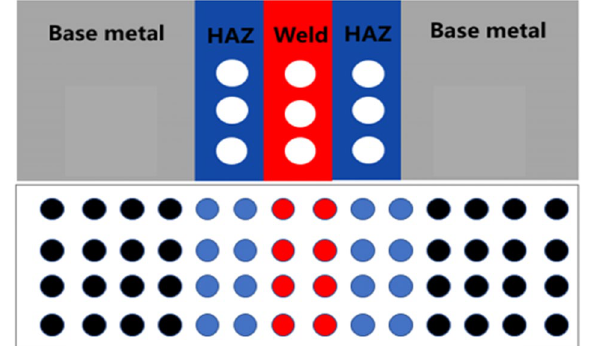
Figure 2. Arrangement of array electrode wires.